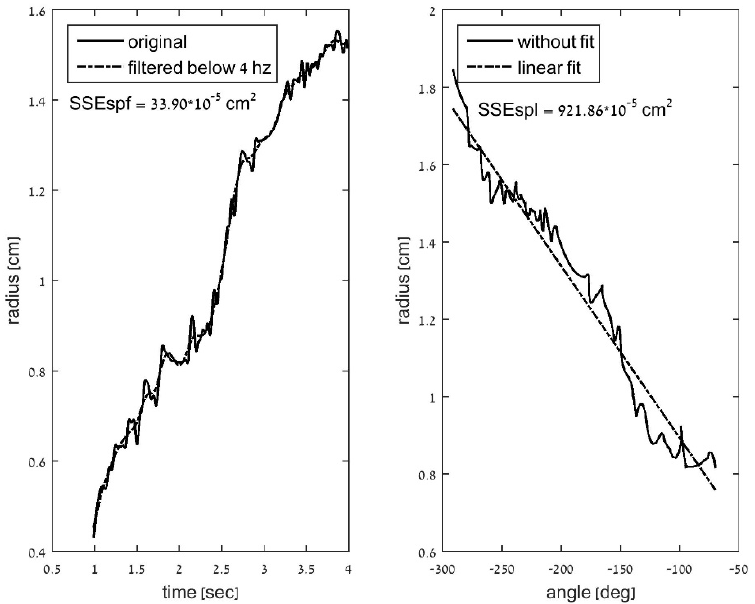
Figure 5. The 300 data points of radial curves for one participant from the ET group: computed radius ( r ) and filtered radius ( rf ) vs. time ( left ); computed radius ( r ) vs. angle and the linear-fit estimation ( rl ) ( right ).